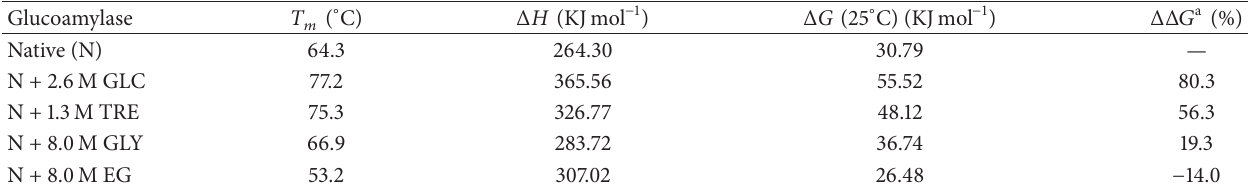
Table 4: Effect of various polyols on the CD and fluorescence spectral characteristics of the thermal-denatured GA at 71 ∘ C. Polyols